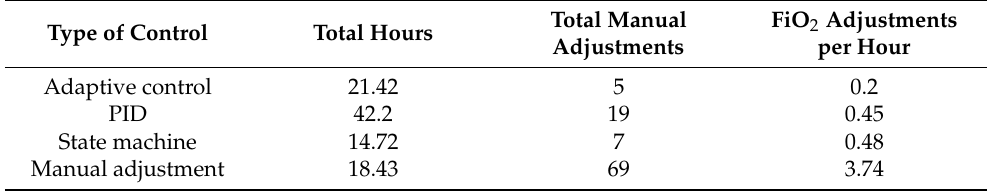
Table 3. Summary of results obtained in